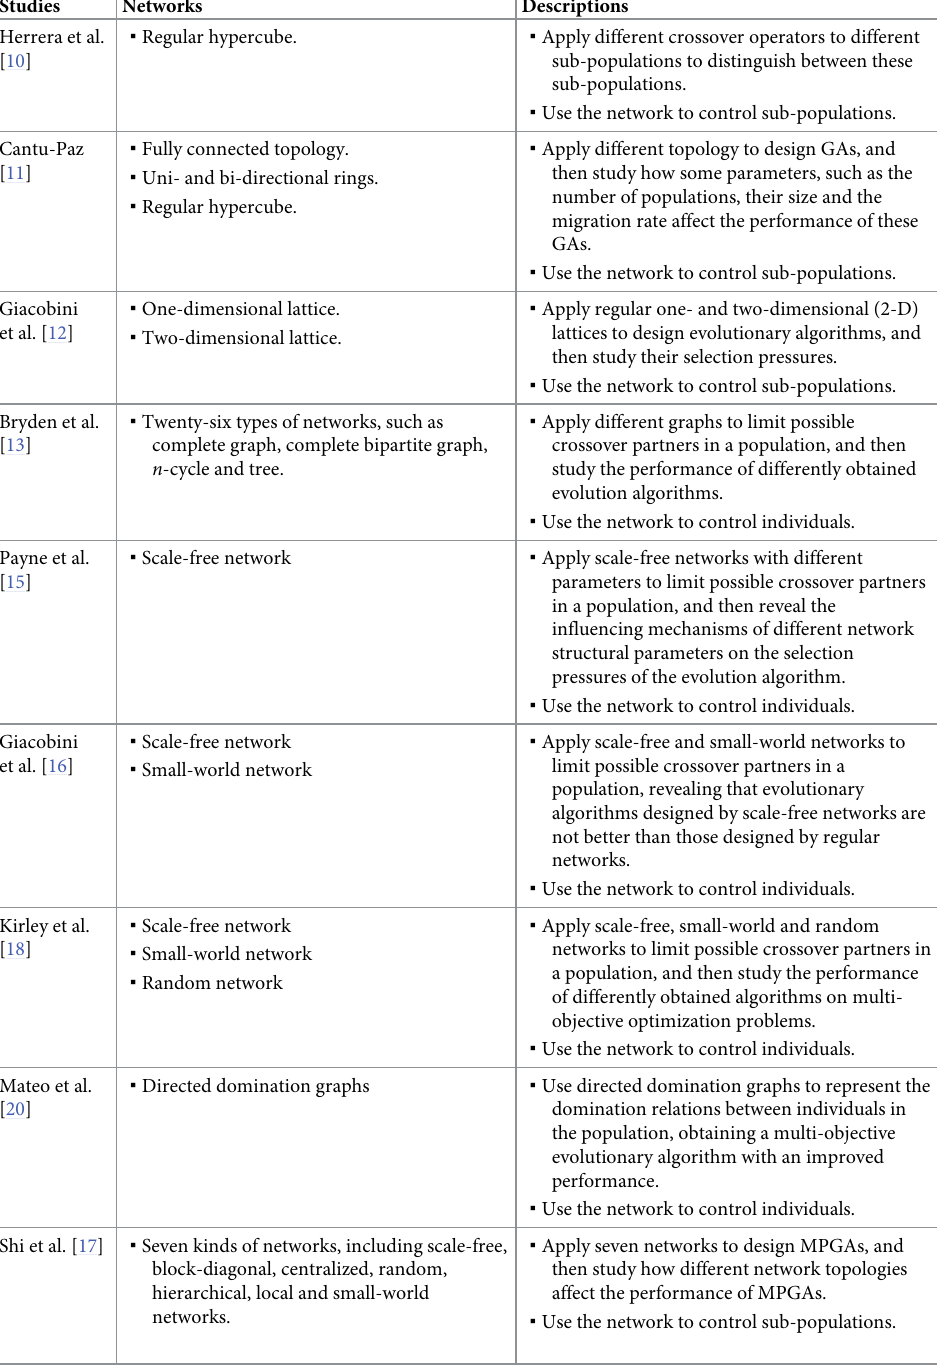
Table 1. Examples of evolutionary algorithms using different